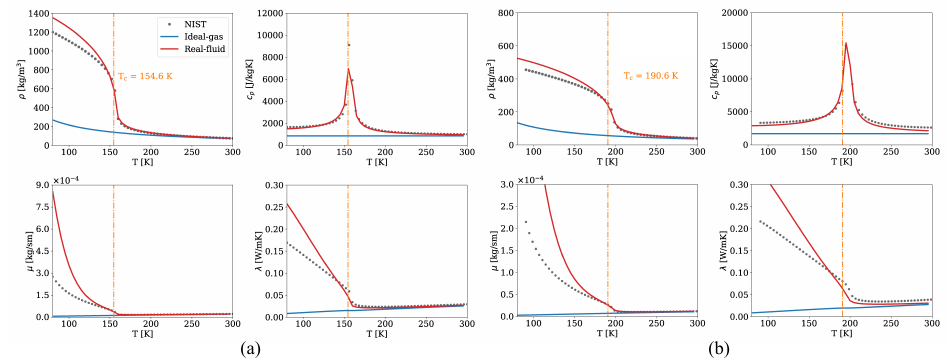
Figure 3. Comparisons of the real-fluid model, ideal gas model, and NIST data for physical properties of the reactants at 5.59 MPa. Symbol: NIST data; red line: real-fluid model; blue line: ideal gas model. ( a ) Physical properties of O 2 . ( b ) Physical properties of CH 4 . For each subgraph, top left: density; top right: constant-pressure heat capacity; bottom left: viscosity; bottom right: thermal conductivity.